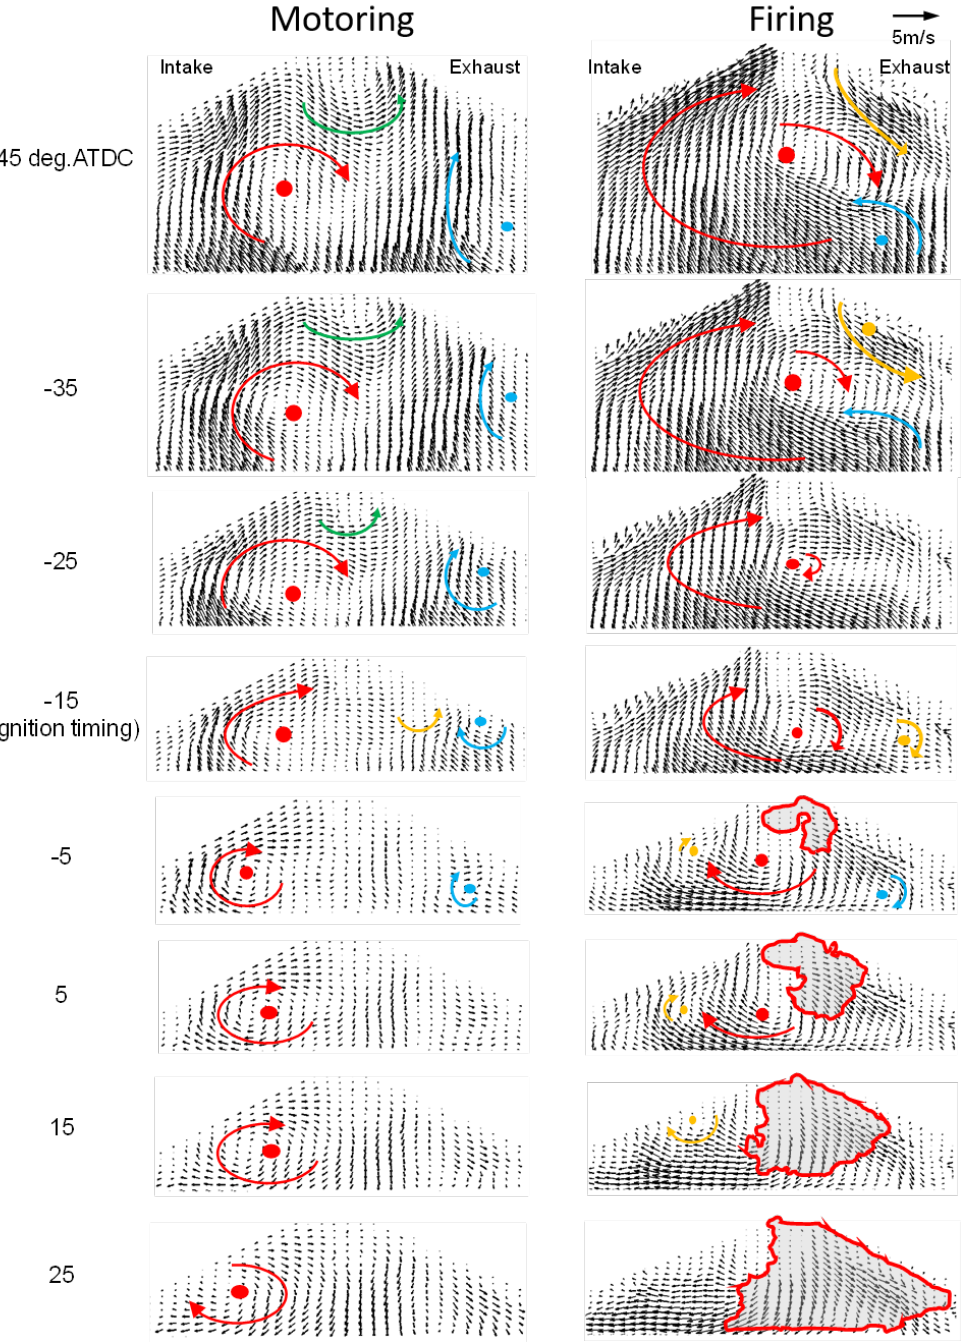
Figure 9. Mean in-cylinder flow velocity of a selected motoring cycle ( left ) and a selected firing cycles ( right ).